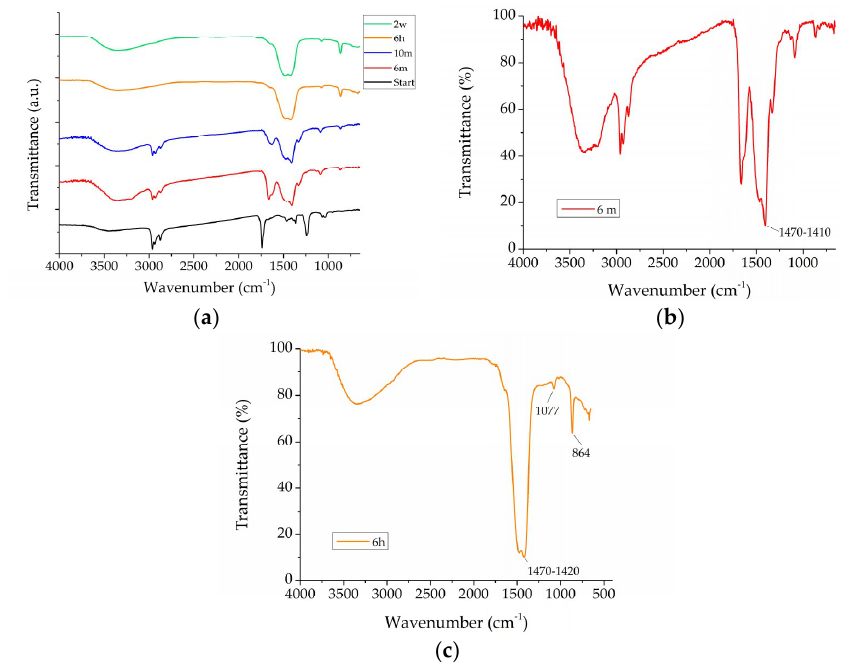
Figure 3. μFT-IR spectra showing the kinetic process of NBU: ( a ) all spectra recorded at different times ( b ) spectrum acquired after six minutes and ( c ) spectrum acquired after six hours. Time intervals: Start, beginning of the reaction (black); 6m, six minutes (red); 10m, ten minutes (blue); 6h, six hours (orange); 2w, two weeks (green).